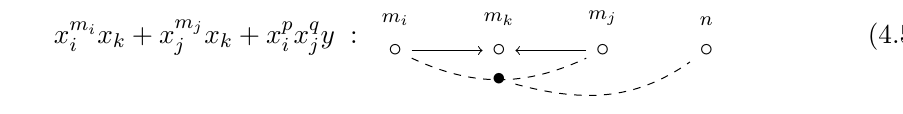
of the four fields. For instance, in (4.4), if q i + q 1 − q k = 1 m i m j